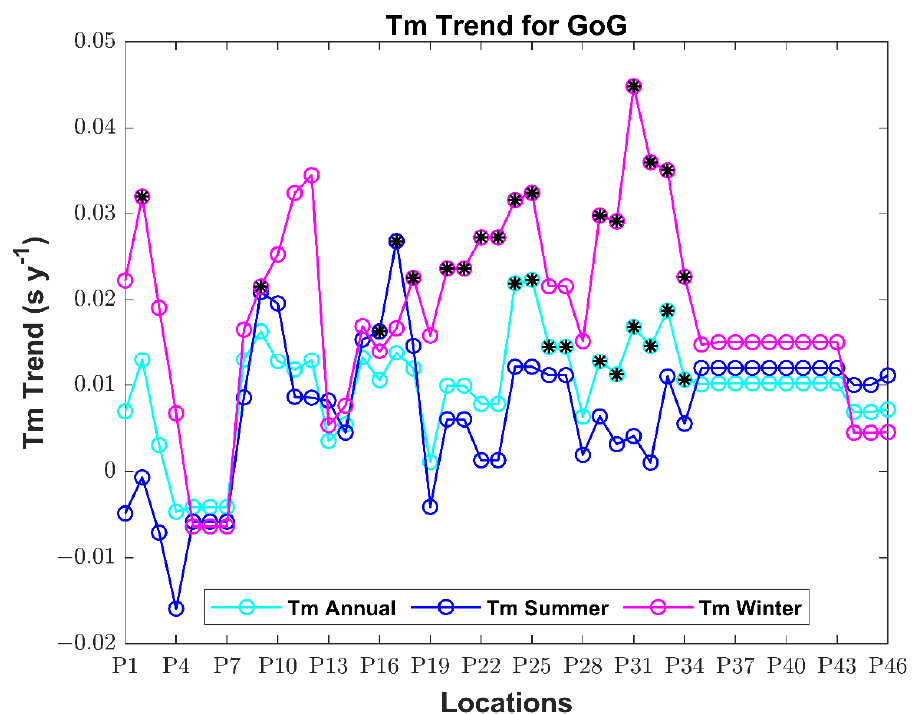
Figure 5. Line plot of the annual, winter, and summer trends of Tm with asterisk showing locations with a significant trend. Asterisk (*) represents significant Tm trend.